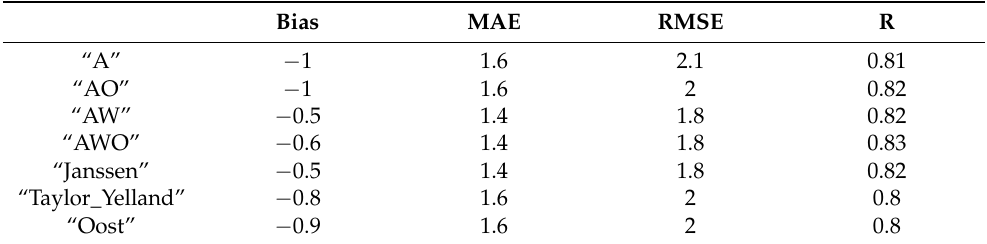
Table 2. Statistical characteristics of model errors in wind speed (m s −1 ) when compared with the altimeter data during the period 10 – 12 December 2006.